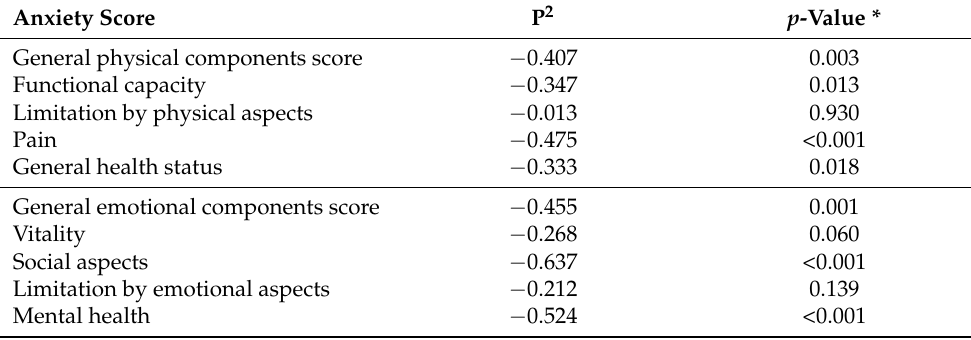
Table 2. Correlation between the anxiety symptoms score and the perception of quality of life of women more than 24 months after undergoing bariatric surgery.